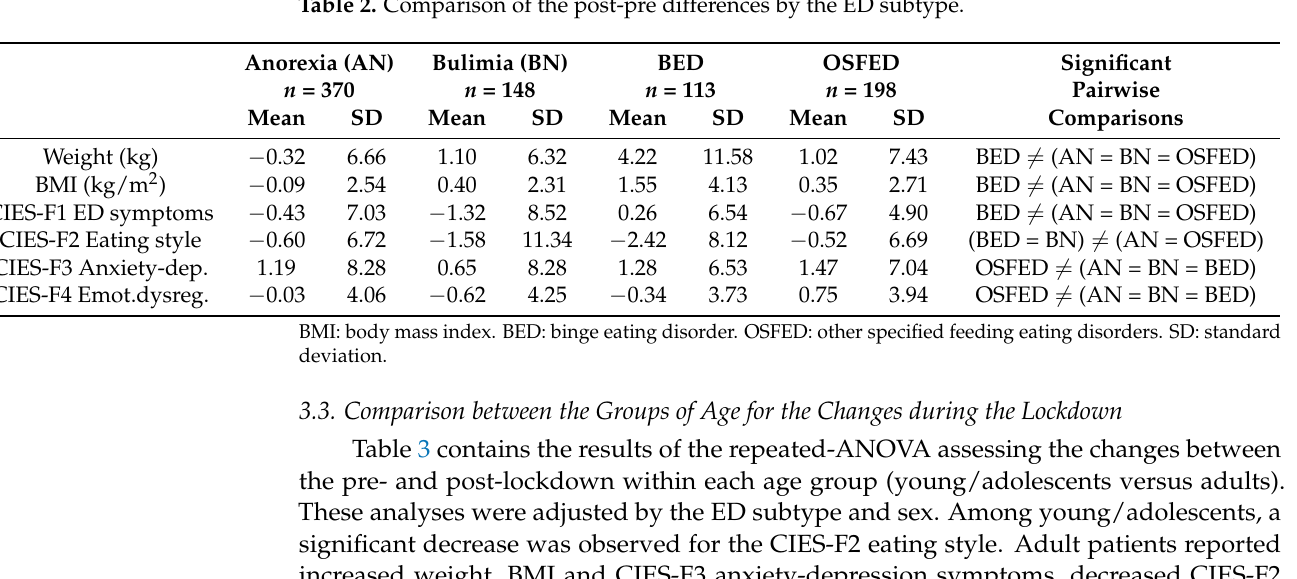
Table 2. Comparison of the post-pre differences by the ED